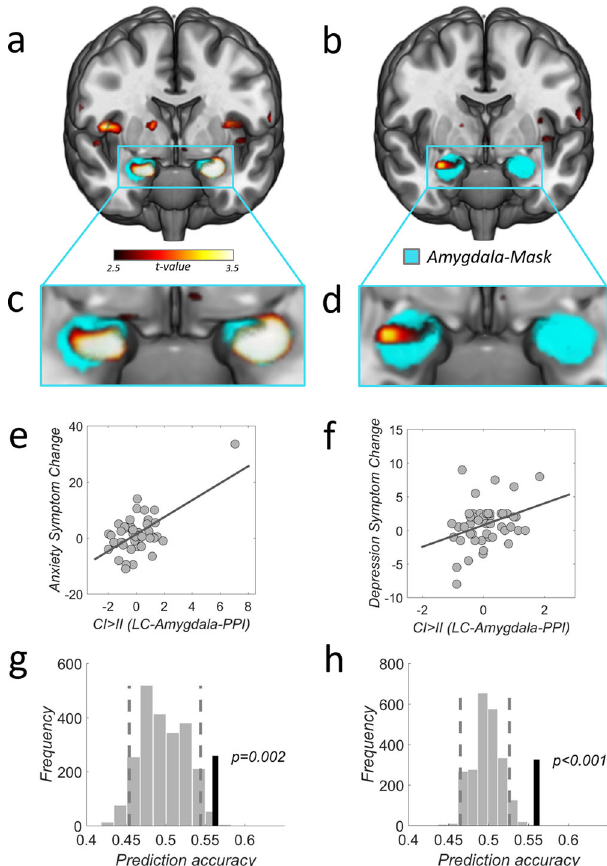
Fig. 5 Functional coupling between LC-NE and amygdala during upregulation response relates to symptom changes. Functional coupling between LC-NE and amygdala during the con fl ict response relates to individual changes in symptom severity for mean anxiety ( a , c ) and depression ( b , d ). e LC-NE-amygdala functional coupling (PPI: CI > II contrast betas extracted within bilateral amygdala mask using LOSO, see “ Methods ” ) relates to mean anxiety-symptom changes ( R = 0.62, simple- regression: p < 0.001, robust regression, p = 0.052) and ( f ) mean depression-symptom changes ( R = 0.34, simple-regression: p = 0.019, robust regression, p = 0.020). Mean symptom changes were de fi ned as the mean between changes after 3 and 6 months. g LC-NE-amygdala functional coupling during upregulation response (extracted with LOSO) predicts mean anxiety symptom severity change above chance ( p = 0.002, prediction accuracy 56.3%). h Similarly, for depression ( p < 0.001, prediction accuracy 56.0%). Prediction analyses were based on a leave- two-subject-out cross-validation procedure; their signi fi cance was tested using a permutation test with 1000 permutations for each possible left out pair combination. Source data are provided as a Source Data fi